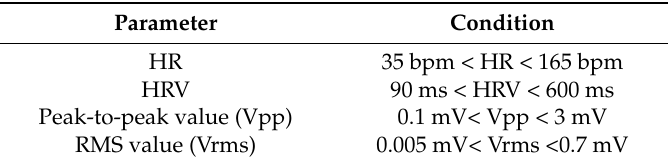
Table 2. Conditions for narrowing down initial channel